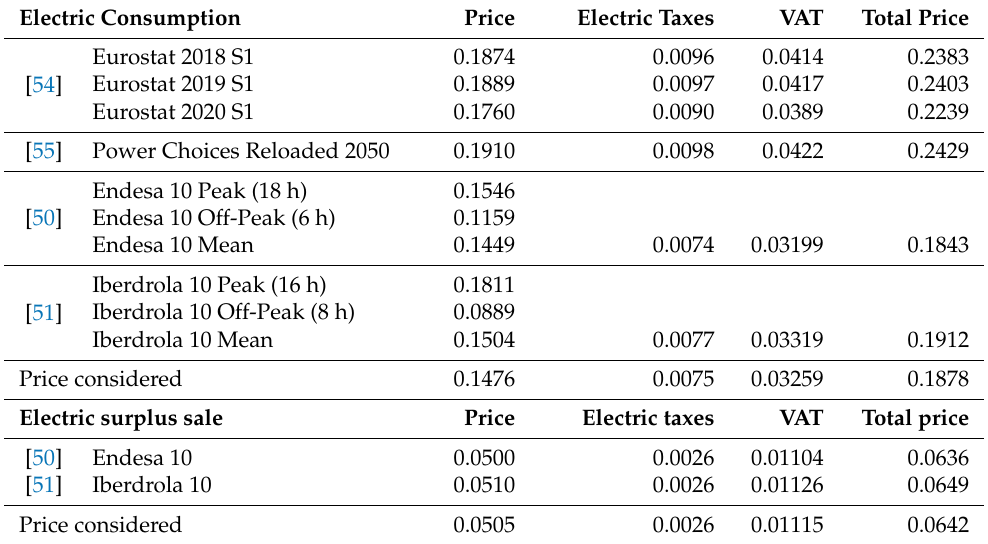
Table 1. Electricity price (in € ).